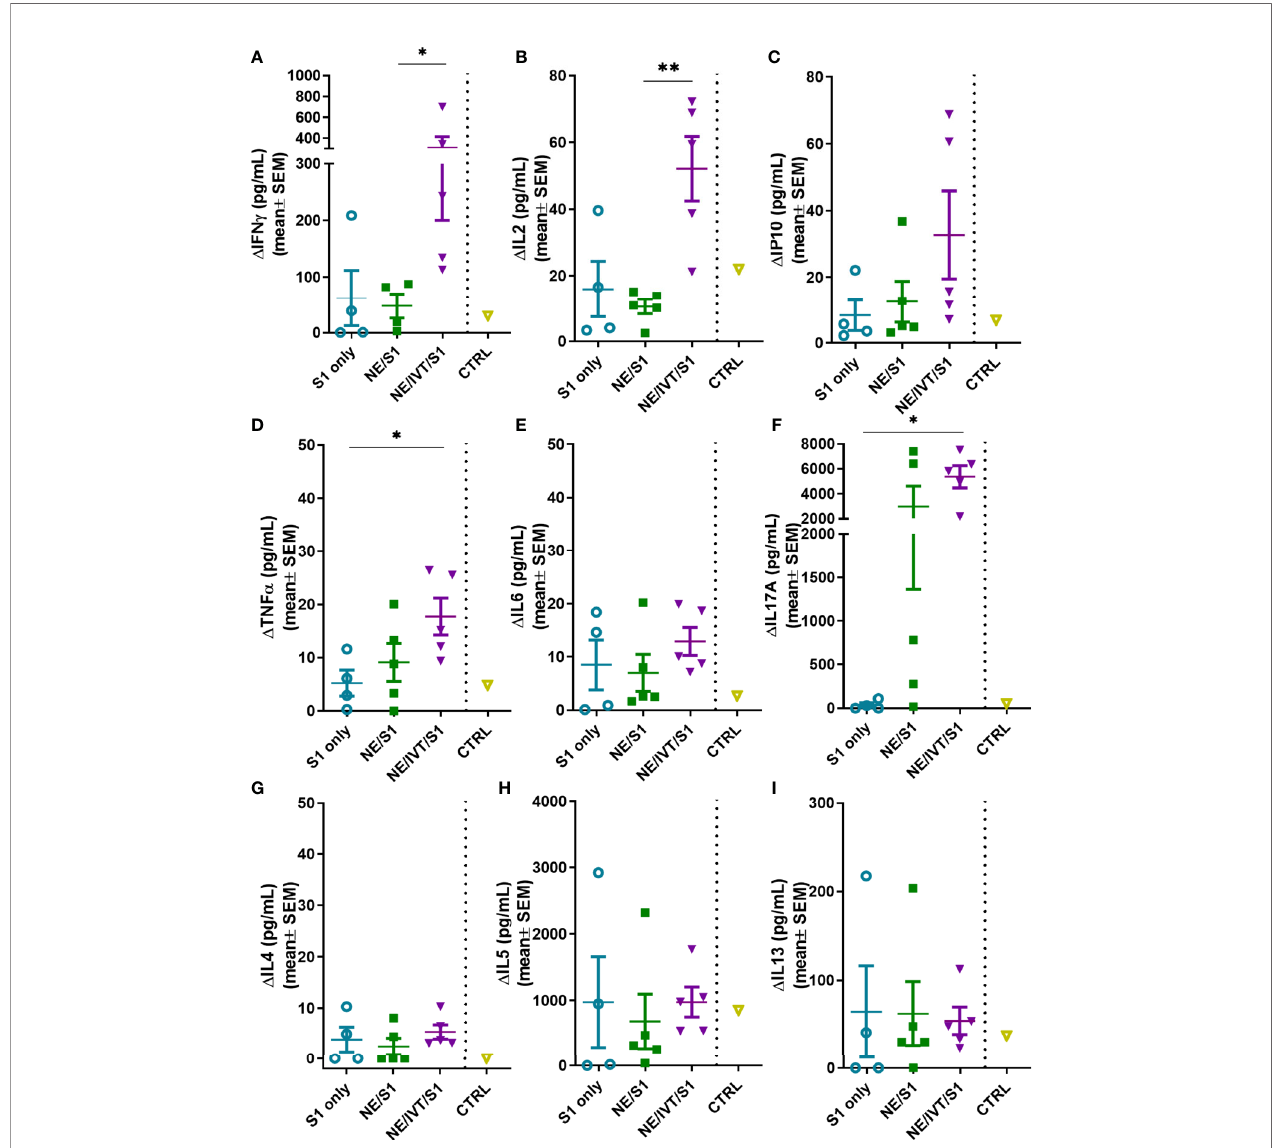
FIGURE 7 | Antigen recall response assessed in the draining lymph nodes (cervical LN). Lymphocytes isolated from the cLNs of mice immunized IN with S1 alone, or with NE, or NE/IVT after the fi nal boost immunization (10 weeks post-initial immunization) were stimulated ex vivo with 5 m g of recombinant S1 for 72h, and levels of secreted cytokines (A) IFN g , (B) IL2, (C) IP10, (D) TNF a , (E) IL6, (F) IL17A, (G) IL4, (H) IL5, (I) IL13 were measured in the supernatant relative to unstimulated cells by multiplex immunoassay. An unvaccinated control was included for comparison. ( n = 5/grp; *p < 0.05, **p < 0.01 by Mann-Whitney U